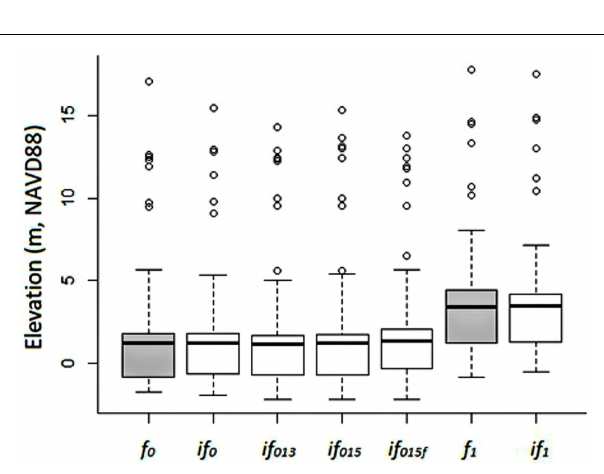
( F -test p -value = 0.70)], 0.90 [two-sample t -test with equal